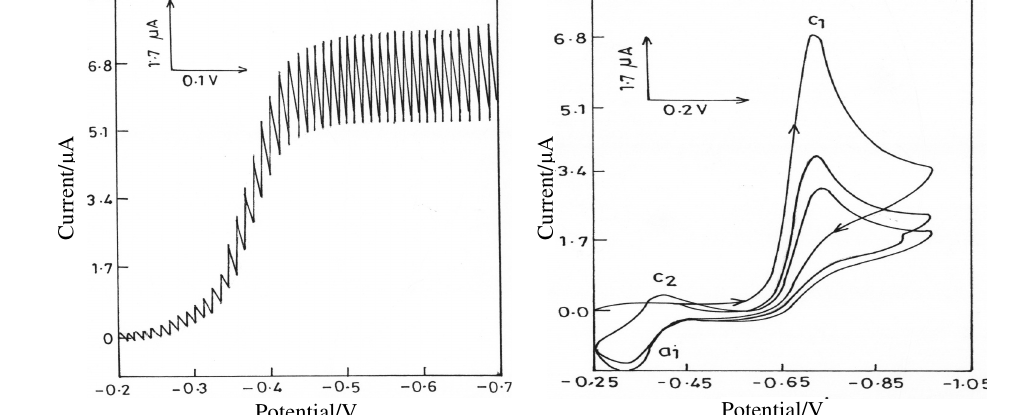
Figure 1 . Typical D.C. polarogram of fluchloralin in pH 8.0, Con:0.5 mM Drop time:3s